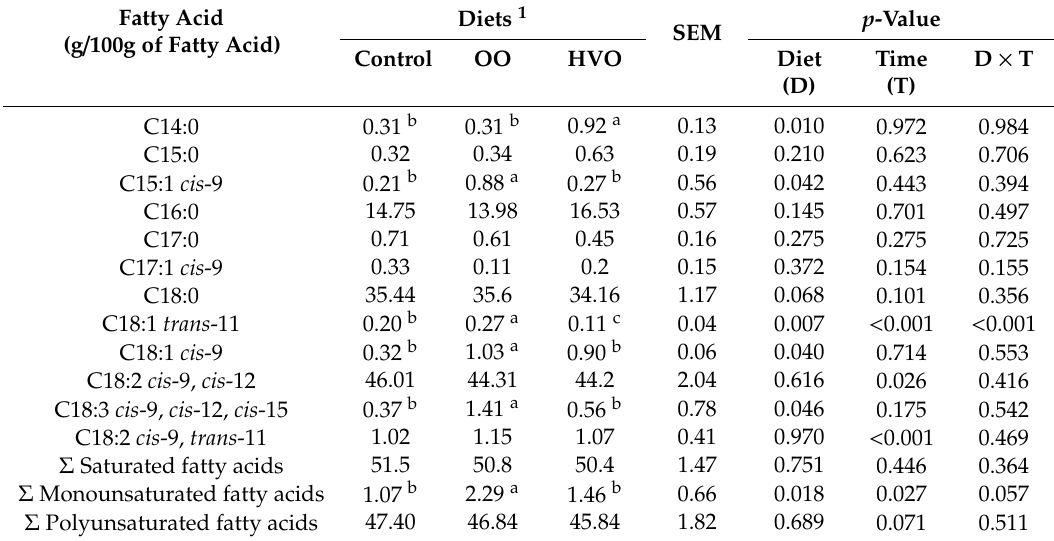
Table 3. Plasma fatty acid composition from cows fed control, olive oil (OO), and hydrogenated vegetable oil (HVO) dietary